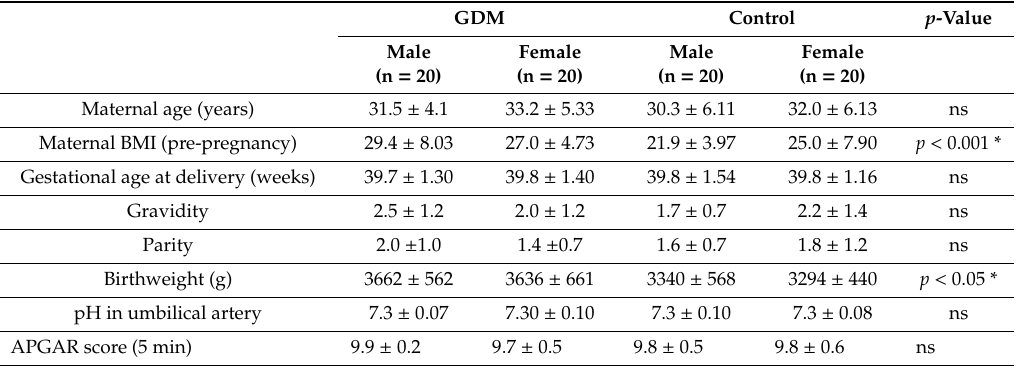
Table 1. Clinical details of the patients with gestational diabetes mellitus (GDM) and of the normal control group (Mean ± SD). The Kruskal–Wallis test was applied to compare clinical outcome data of the groups.